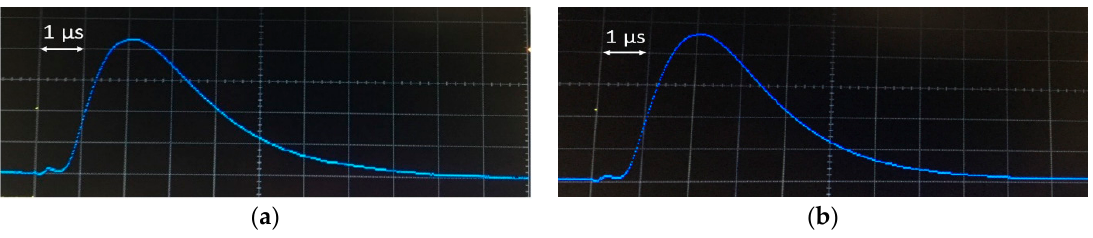
Figure 8. Oscillograms of lidar signals recorded during the atmospheric measurements at a wavelength of ( a ) 3415.711 nm (on-line CH 4 ) and ( b ) 3417.484 nm (off-line CH 4 ).